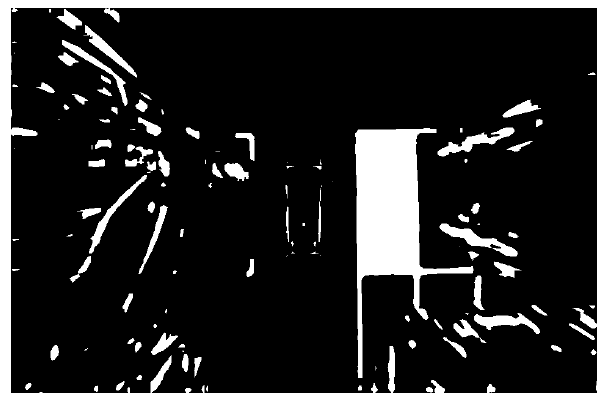
Figure 22. Connected region extraction.